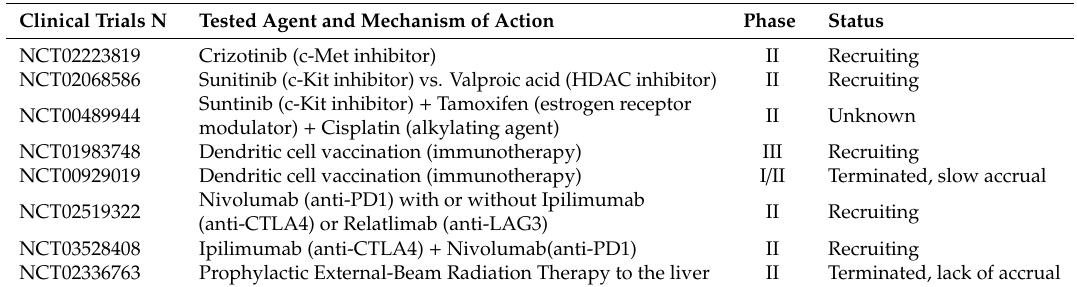
Table 2. Current adjuvant trials in uveal